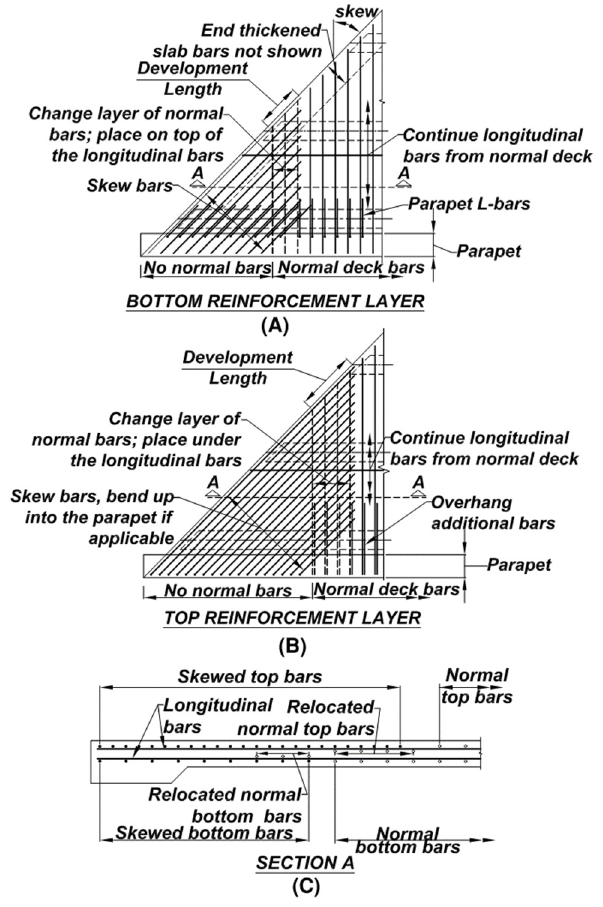
Figure 3. The proposed detail for the acute corner of bridge decks with larger than 20 degree skew showing ( A ) bottom reinforcement layer, ( B ) top reinforcement layer, ( C ) and section cut.